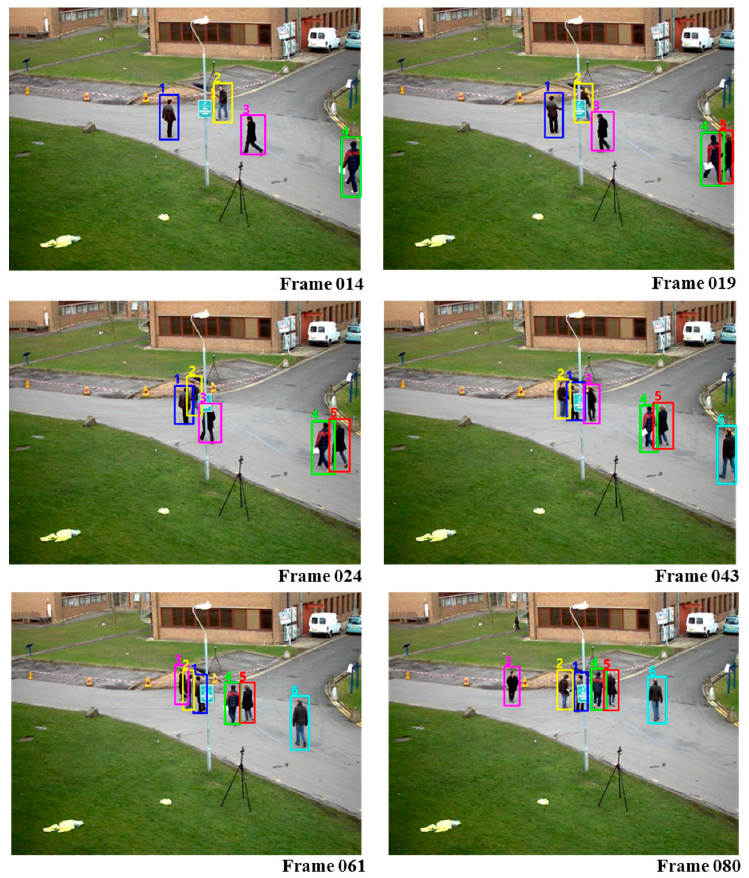
Figure 6. Tracking results of our system on PETS2009.